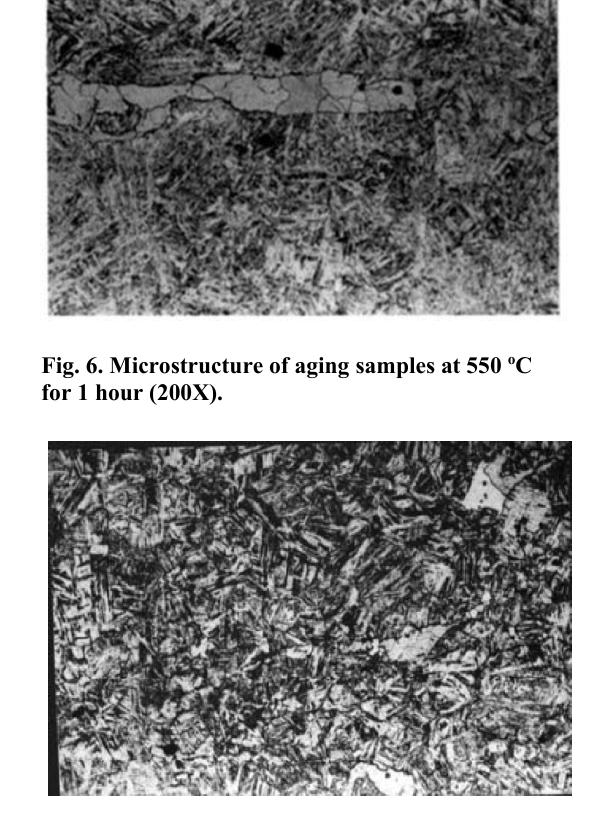
Fig. 7. Microstructure of aging samples at a temperature of 550 oC for 5 hours (100X).